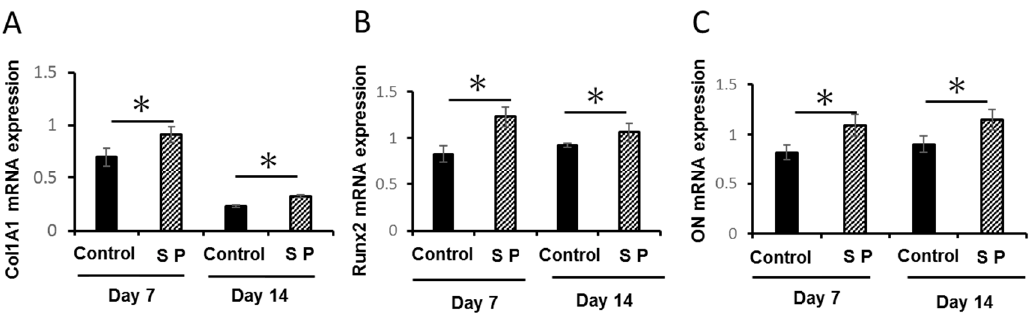
Figure 3. Effects of the SP on mRNA expression of ( A ) collagen 1-alpha 1 (COL1A1), ( B ) Runx2, and ( C ) osteonectin (ON). The gene expression was investigated by quantitative RT-PCR (* P < 0.05).